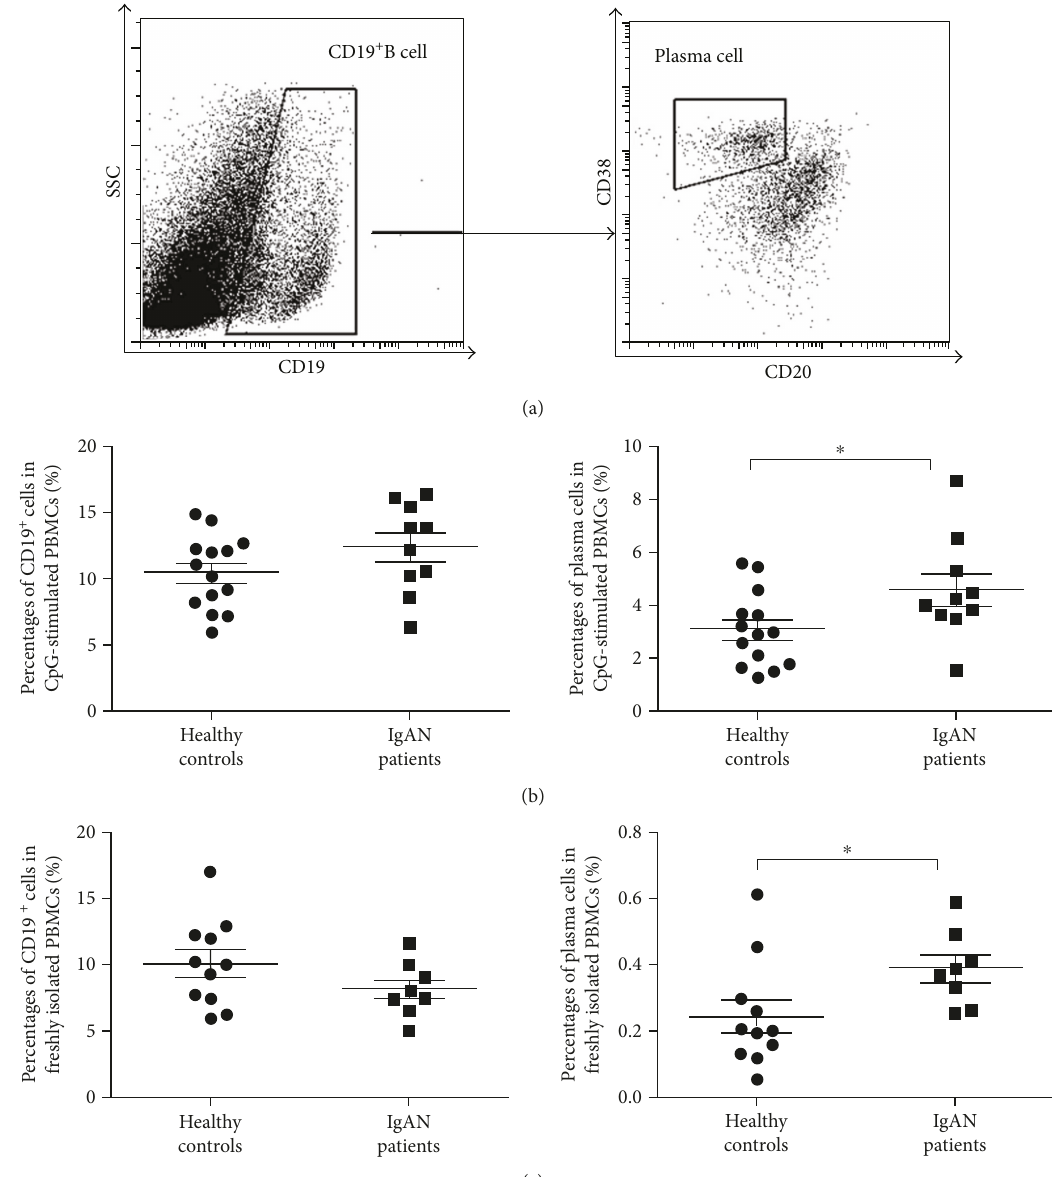
Figure 4: Plasma cell di ff erentiation was augmented in CpG2216-activated PBMCs ex vivo. PBMCs of di ff erent donors were prepared by fi coll-paque density centrifugation and cultured with pDCs-preferred CpG2216 for 6 days, followed by surface marker labeling and analysis in fl ow cytometry. (a) CD19 + cells di ff erentiated into plasma cells (CD19 + CD38 high CD20 low ) after CpG2216 stimulation for 6 days. (b) The percentage of CD19 + cells and plasma cells in ex vivo PBMCs culture after 6 days (healthy donors, n = 14 ; IgAN patients, n = 10 ). (c) The percentage of CD19 + cells and plasma cells in fresh PBMCs from IgAN patients and healthy controls (healthy donors, n = 11 ; IgAN patients, n = 8 ). ∗ p < 0 05